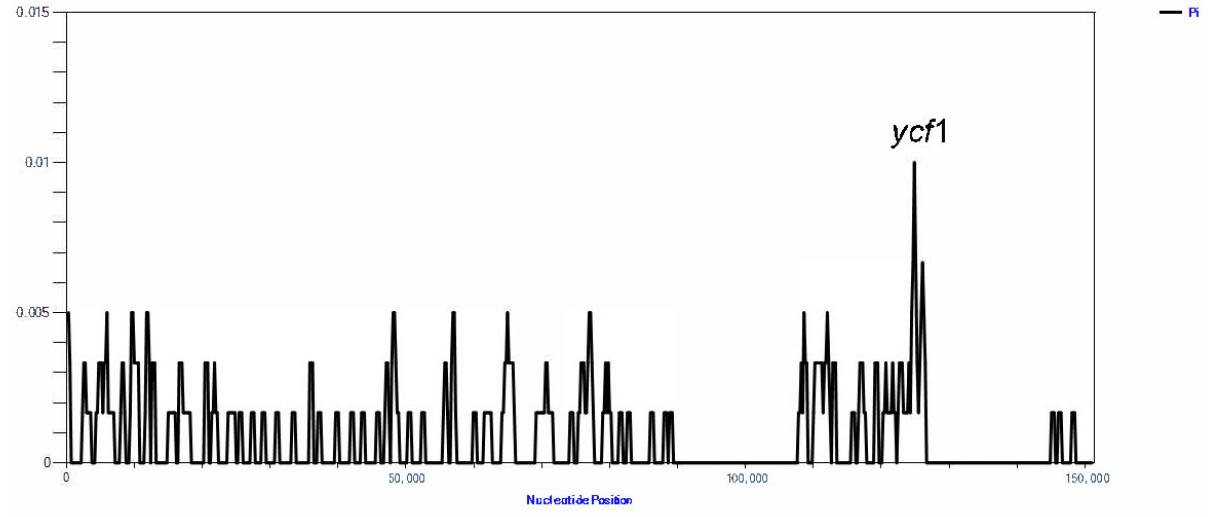
Figure 6. Sliding window analysis of the entire chloroplast genome of Opisthopappus species (window length: 1000 bp; step size: 300 bp). X-axis: position of the window; Y-axis: nucleotide diversity of each window.